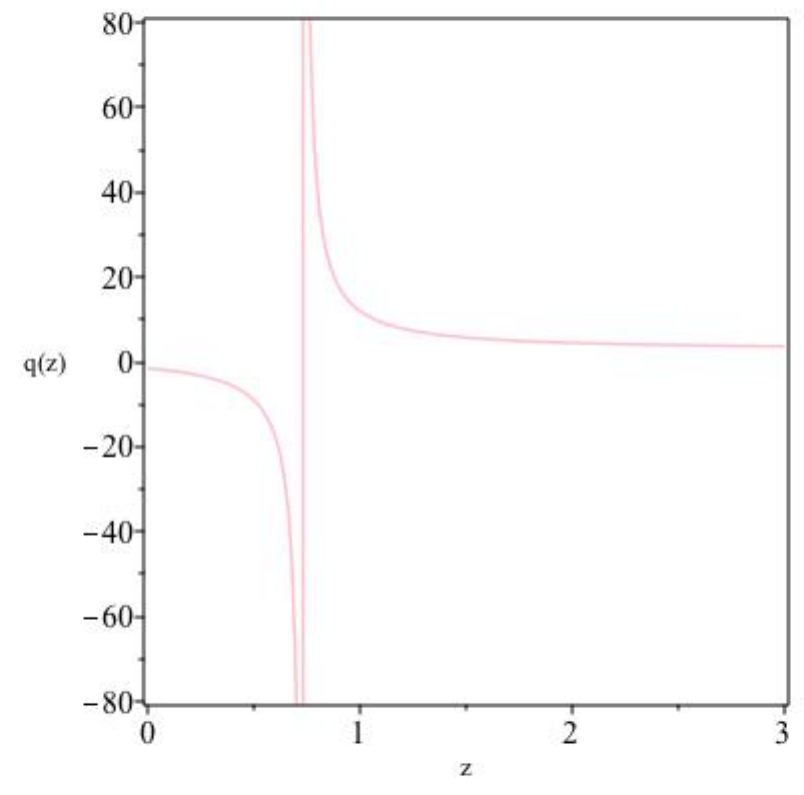
Figure 7. The deceleration parameter in terms of redshift for α = 1 = γ . Here, a mathematical singularity occurs at the value of z for which γ ( 1 + z ) 2 − ( α + 2 ) = 0, and hence the singular point can be shifted either way by choosing appropriate values of α and γ